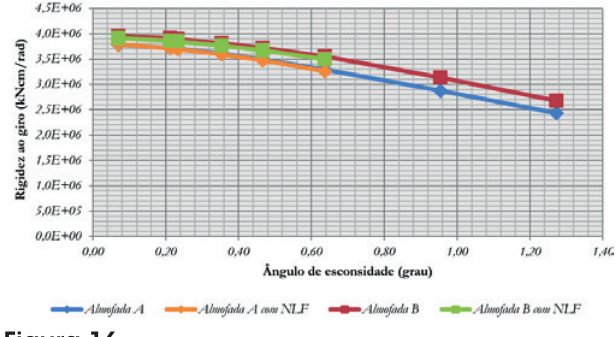
Rigidez ao giro × ângulo de esconsidade da